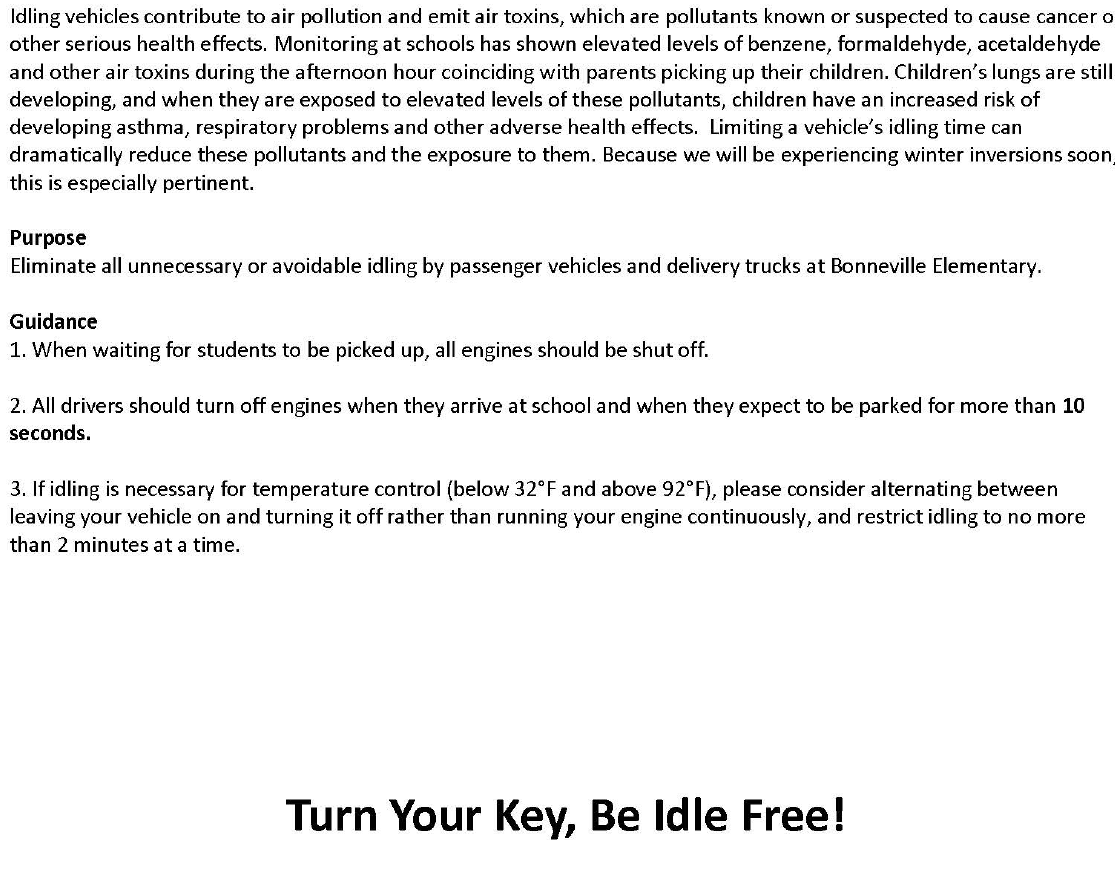
Figure A7. Idle-free schools policy for parents and delivery truck